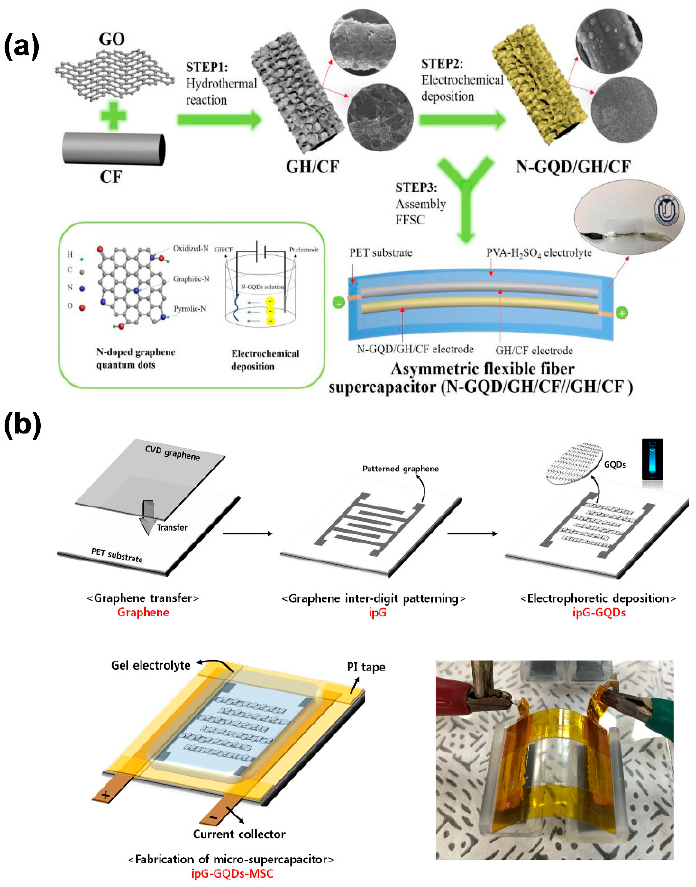
Figure 10. ( a ) The synthesis process of N-GQDs on carbon fiber/graphene hydrogel with a hydrothermal reaction followed by electrodeposition: the symmetric supercapacitor was fabricated on a flexible substrate and PVA/H 2 SO 4 to ensure the flexibility, portability, and stability. Reproduced from Reference [122]. Copyright Elsevier, 2019. ( b ). Schematic illustration of ipG-GQDs-MSC fabrication starting from chemical vapor deposition (CVD) onto a polyethylene terephthalate (PET) surface, patterning graphene to create interdigitated electrodes: the GQDs are deposited by using electrophoretic. Reproduced from Reference [170]. Copyright Elsevier,